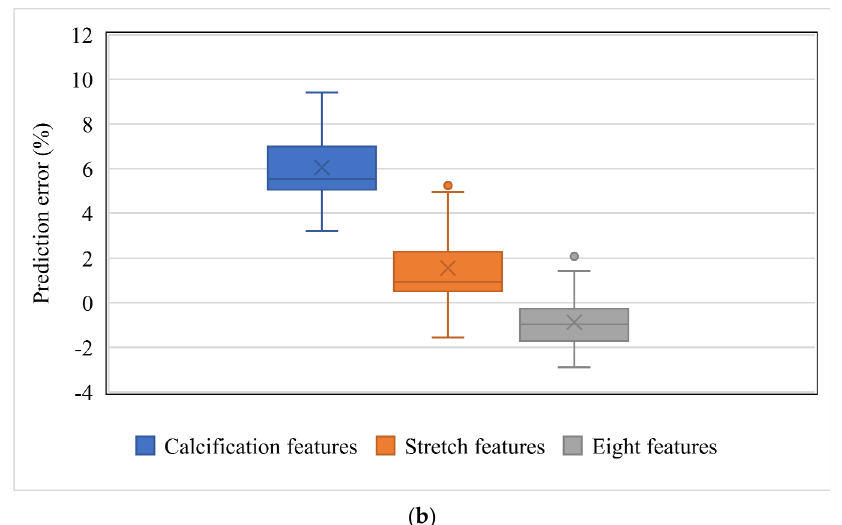
Figure 5. Influence of feature selection on SVR-P prediction errors: ( a ) scatter plot, and ( b ) box plot.